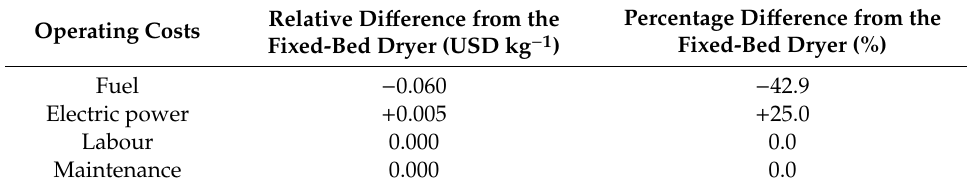
Table 5. Fixed-bed dryer and pneumatic dryer di ff erences in operating